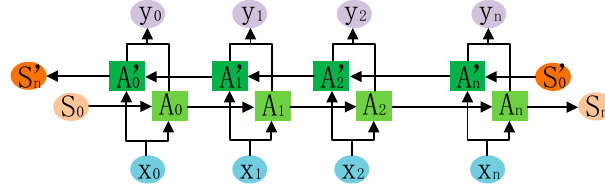
Figure 5. Single-layer BLSTM neural network structure.